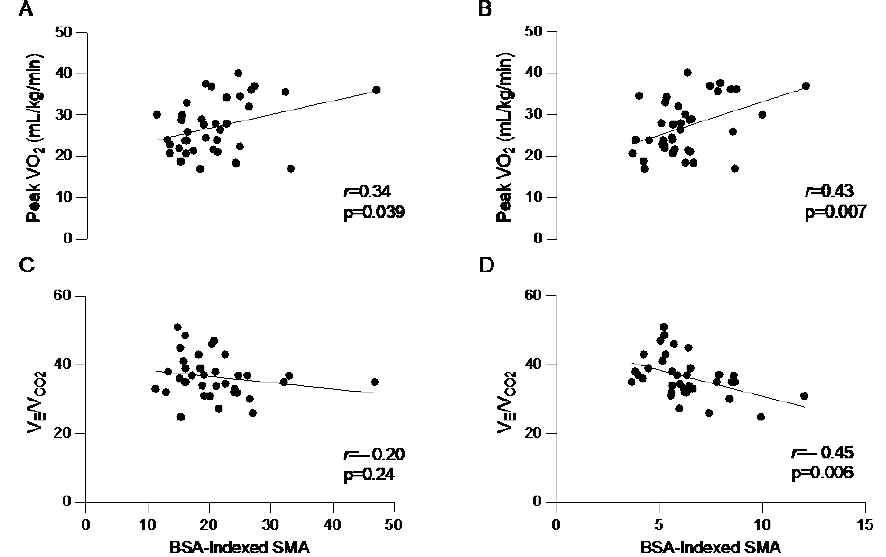
Figure 3. Correlation between BSA-indexed anterior SMA with ( A ) peak VO 2 , ( C ) V E /V CO2 and BSA-indexed paraspinal SMA with ( B ) peak VO 2 and ( D ) V E /V CO2 . VO 2 —oxygen consumption; V E /V CO2 —minute ventilation/carbon dioxide production; BSA—body surface area; SMA—skeletal muscle area. Pearson correlation testing was performed.